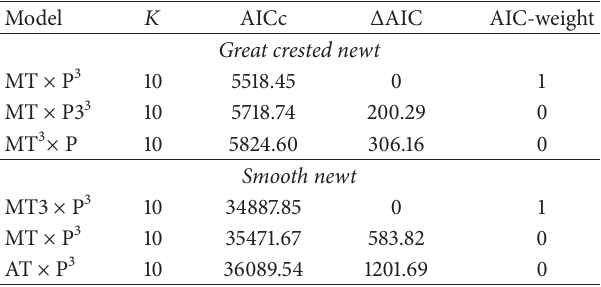
Table 5: Model selection table based on AIC-values for the three mostsupportedmixedmodelsexploringbreedingmigrationpattern for T. cristatus (upper) and L. vulgaris